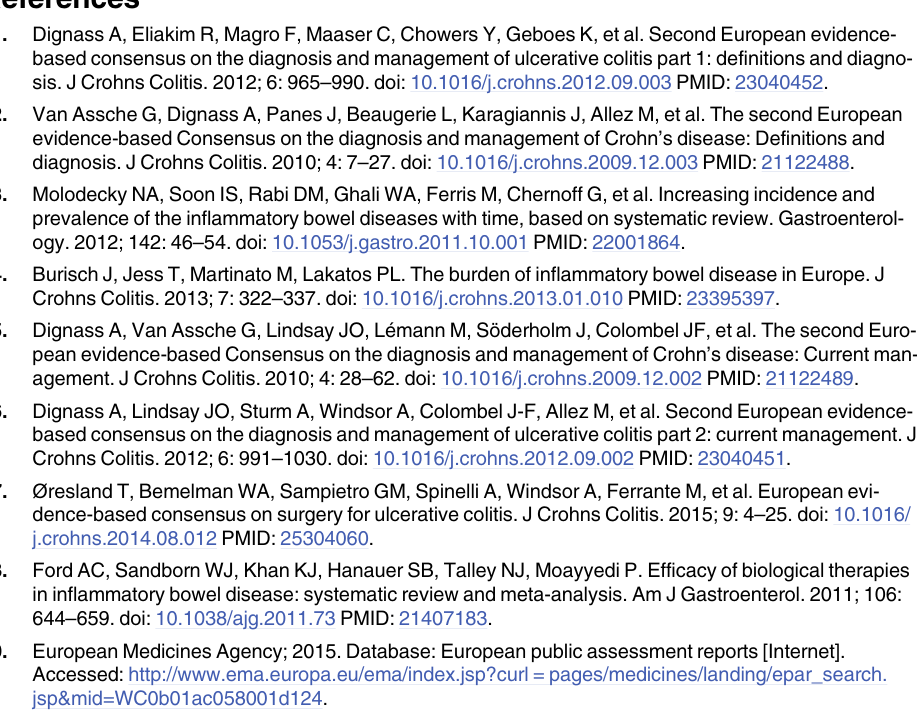
S1 Table. Inclusion and exclusion criteria. S2 Table. Fulfillment of items of quality assessment checklists. S3 Table. PRISMA